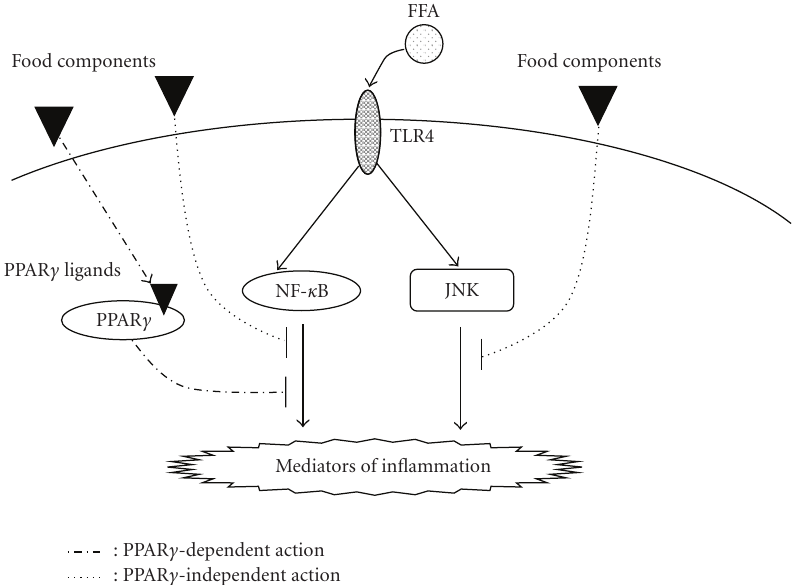
Figure 2: Signaling pathway of inflammatory gene expressions in obese adipose tissue and the strategy to prevent the obese-related pathologies by food components.